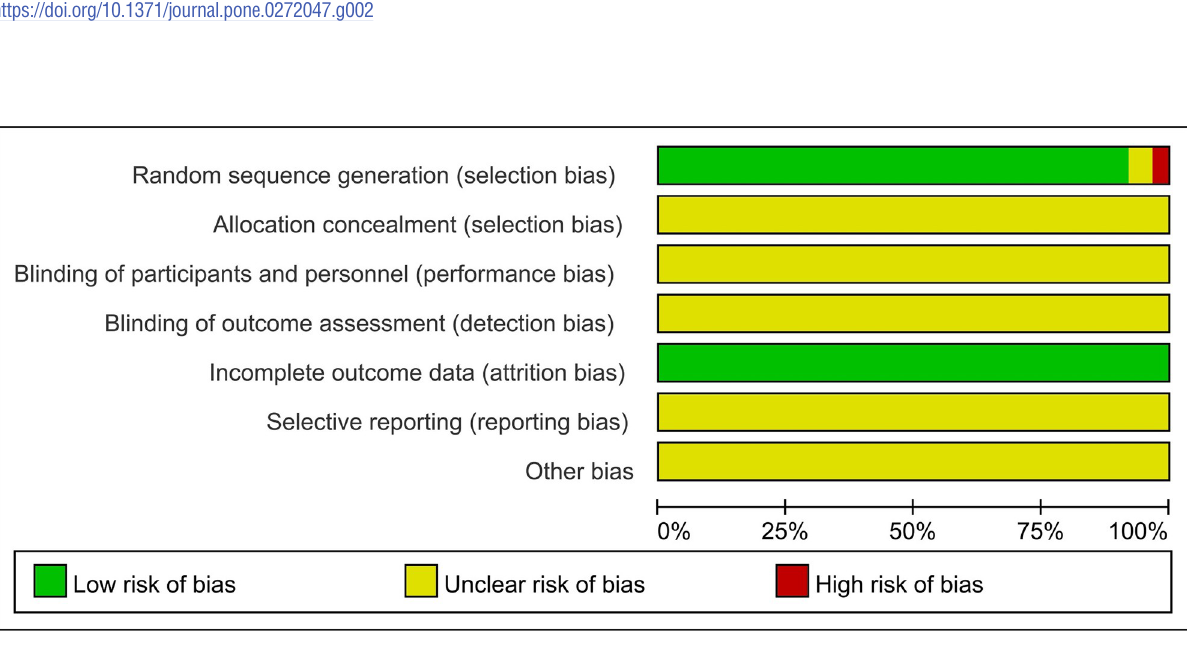
Fig 3. Risk-of-bias graph.